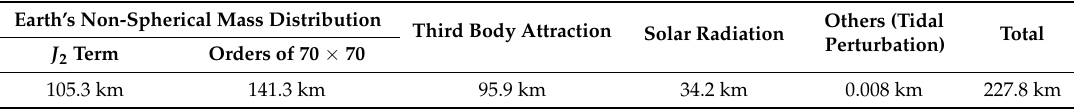
Table 1. GEO SAR orbit drifts after 10 days when considering each perturbation alone. Earth’s Non-Spherical Mass